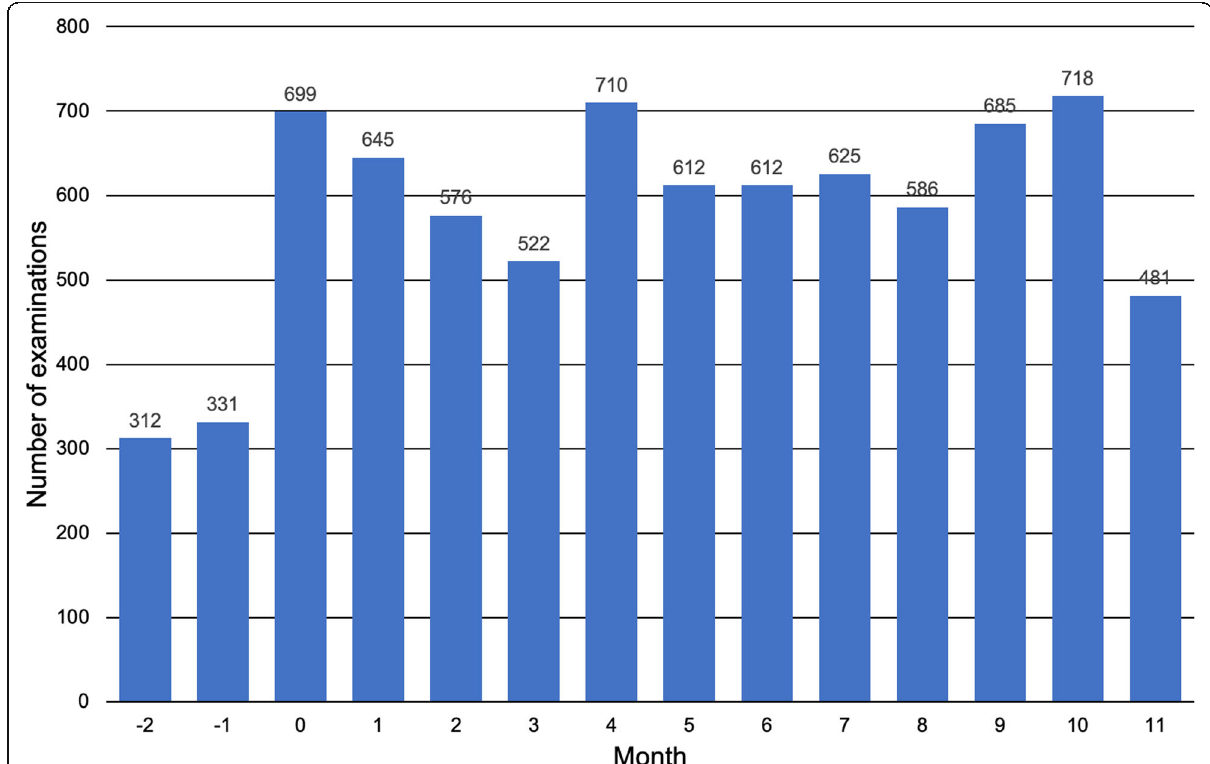
Fig. 2 Numbers of imaging examinations reported using structured oncology reports. Month 0 indicates time point of department-wide roll out of structured oncology reports. SOR, structured oncology